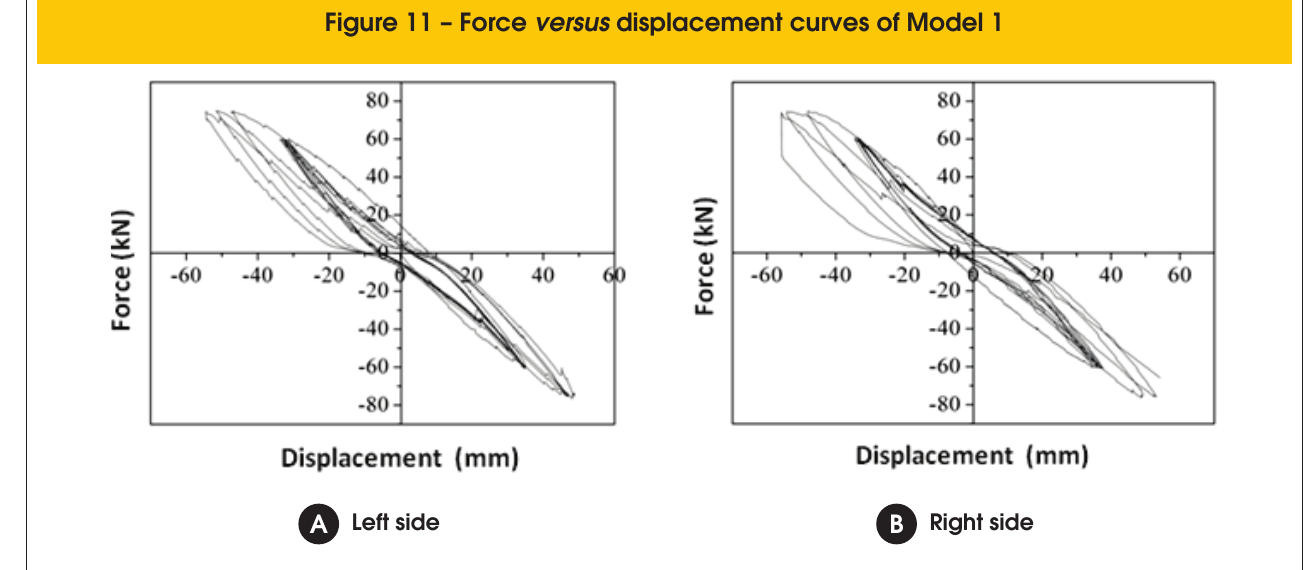
Figure 11 – Force versus displacement curves of Model 1